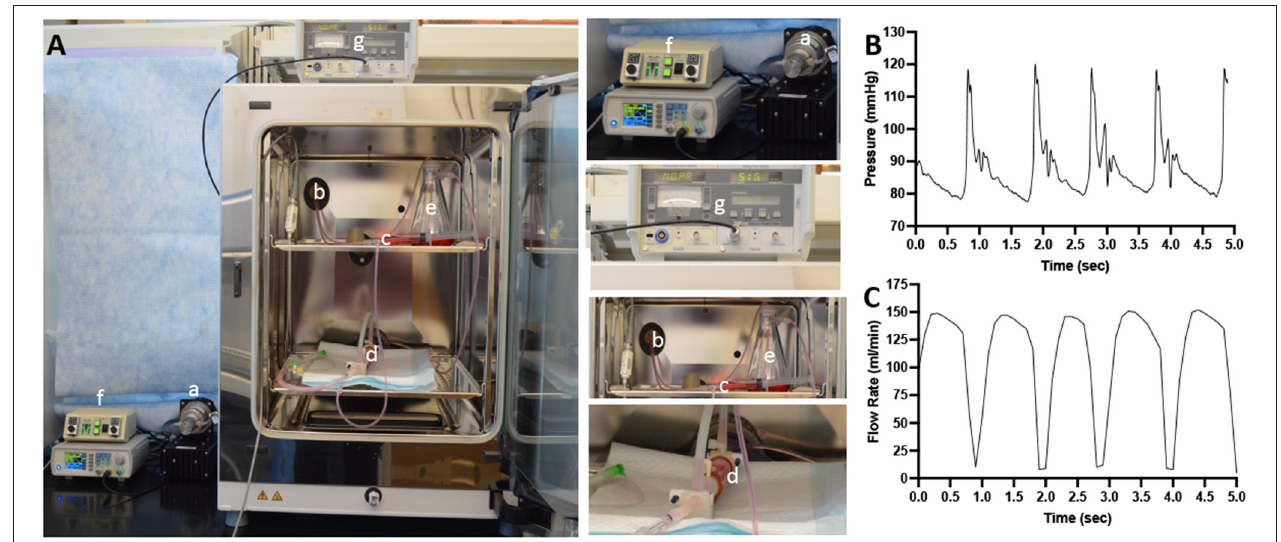
FIGURE 1 | Schematic diagram of the ex vivo bioreactor system. (A) A computer controls a gear pump (a) that is capable to generate pulsatile flow conditions. The tubing from the gear pump passes through a port (b) of the CO 2 incubator. The culture medium then passed through a low-pass filter (c) and through the lumen of the explanted arteries in the bioreactor housing compartment (d) and into the flow reservoir (e). The flow is monitored via pressure sensor (f) and an ultrasonic flowmeter (g). (B) A representative signal of the pressure within the flow system. (C) A representative signal of the flow rate within the flow system.